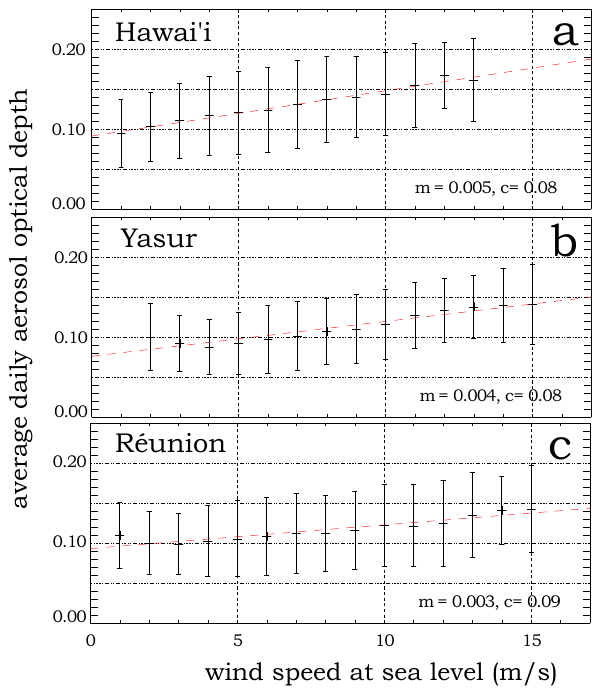
Figure 11. Daily average AOD at 550nm measured from MODIS, Fig. 11. Daily average AOD at 550 nm measured from MODIS, Aqua between 2002 and 2008 with 50km of the coasts of (a) Aqua between 2002 and 2008 with 50 km of the coasts of a) Hawai’i Hawai’i, (b) Yasur and (c) Réunion plotted as a function of hori- , b) Yasur and c) R´eunion plotted as a function of horizontal wind zontal wind speed at sea level from ECMWF. Error bars show the speed at sea level from ECMWF. Error bars show the standard de- standard deviation in AODs for bin intervals of 1ms − 1 viation in AODs for bin intervals of 1 m/s.